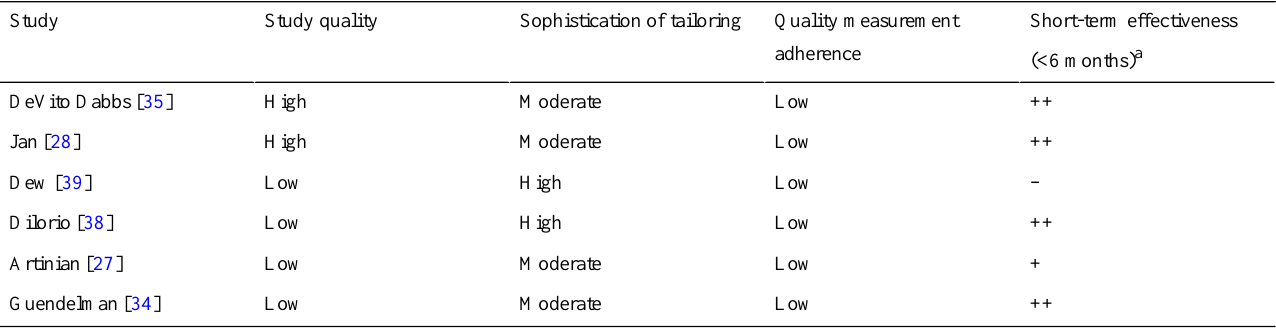
Table 4. Effectiveness of short-term interventions (<6 months).